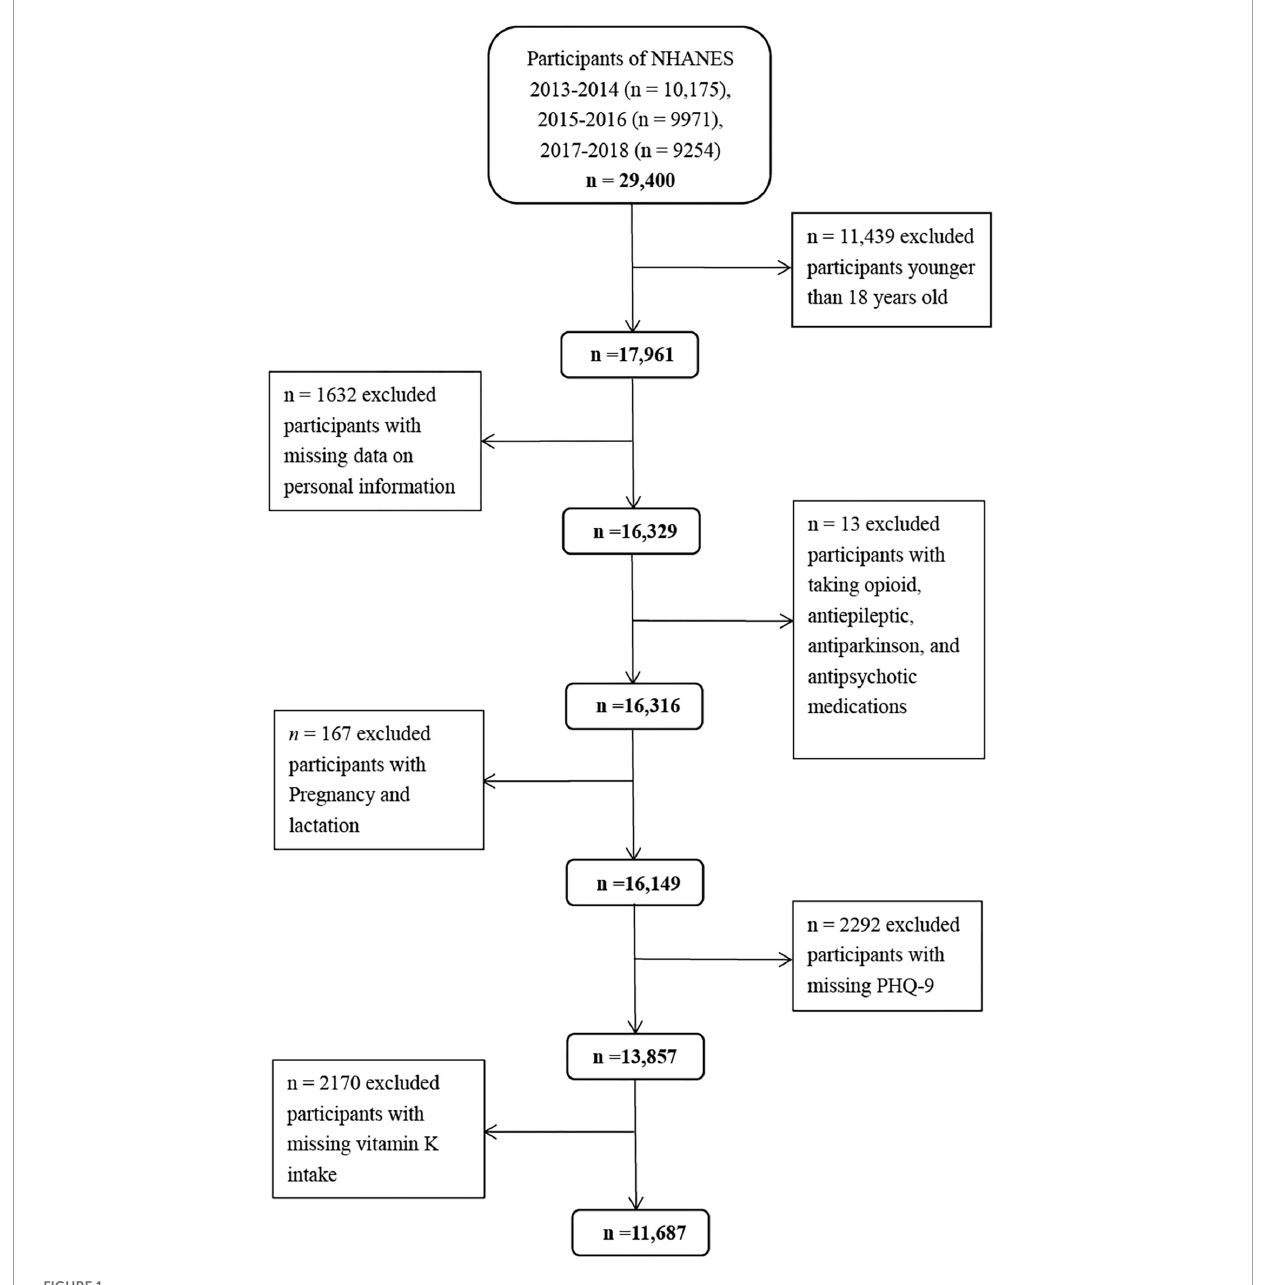
FIGURE1 Flow chart of study